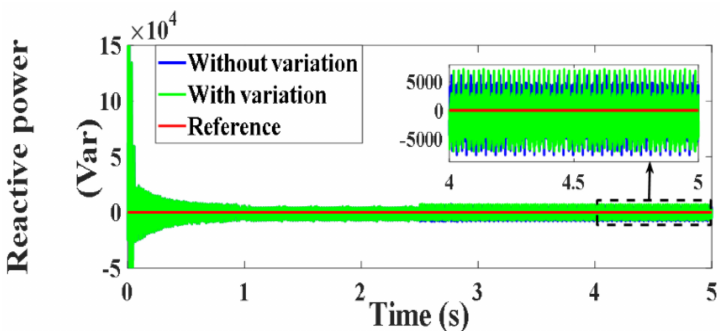
Figure 146. Reactive power under PVC